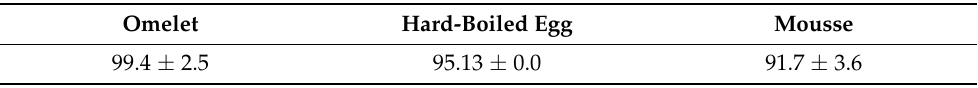
Table 2. Docosahexaenoic acid (DHA) recovery (%) in the three DHA-enriched matrices. Omelet Hard-Boiled Egg